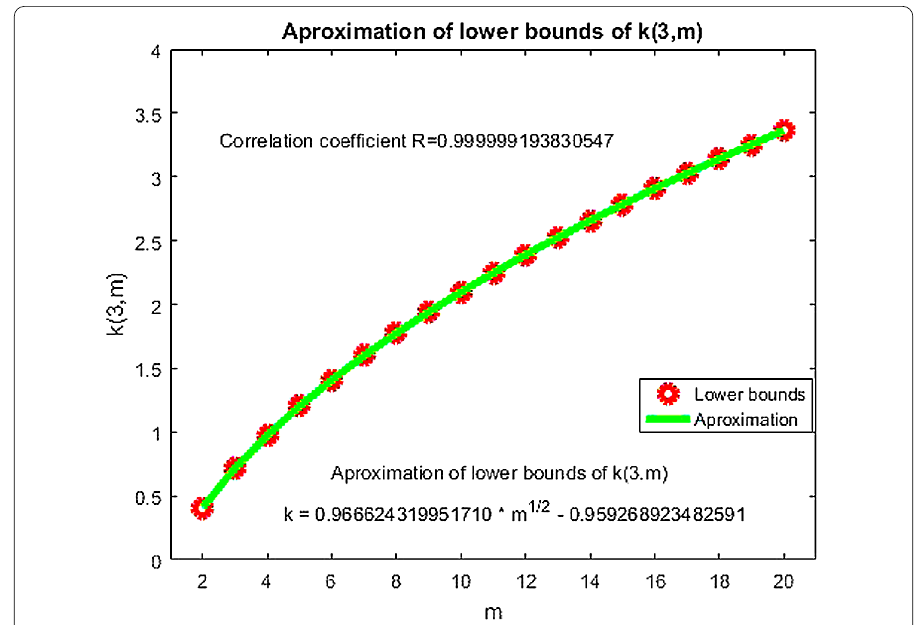
Figure 1 Lower bounds for n =